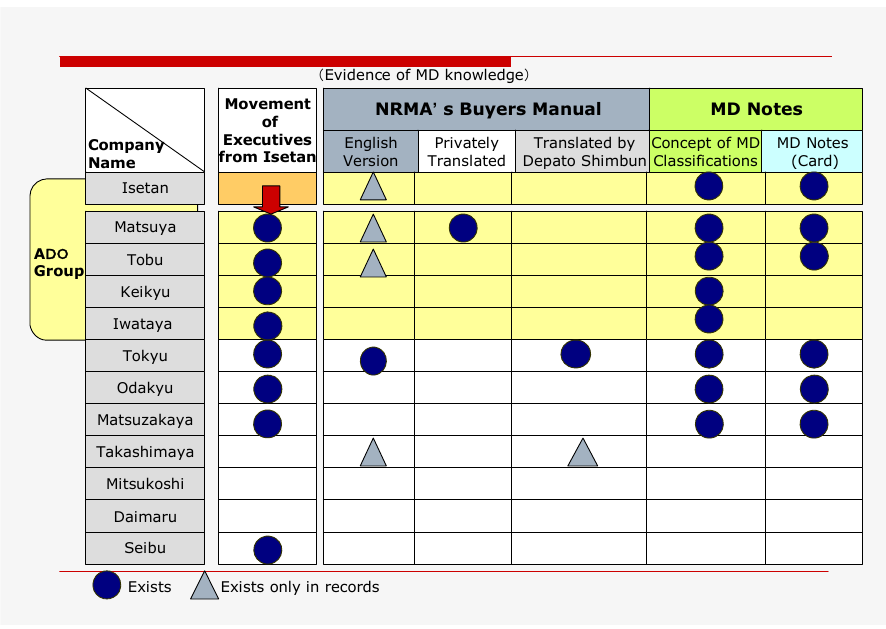
Figure 4. Knowledge transfer of “Buyers Manual” and “MD